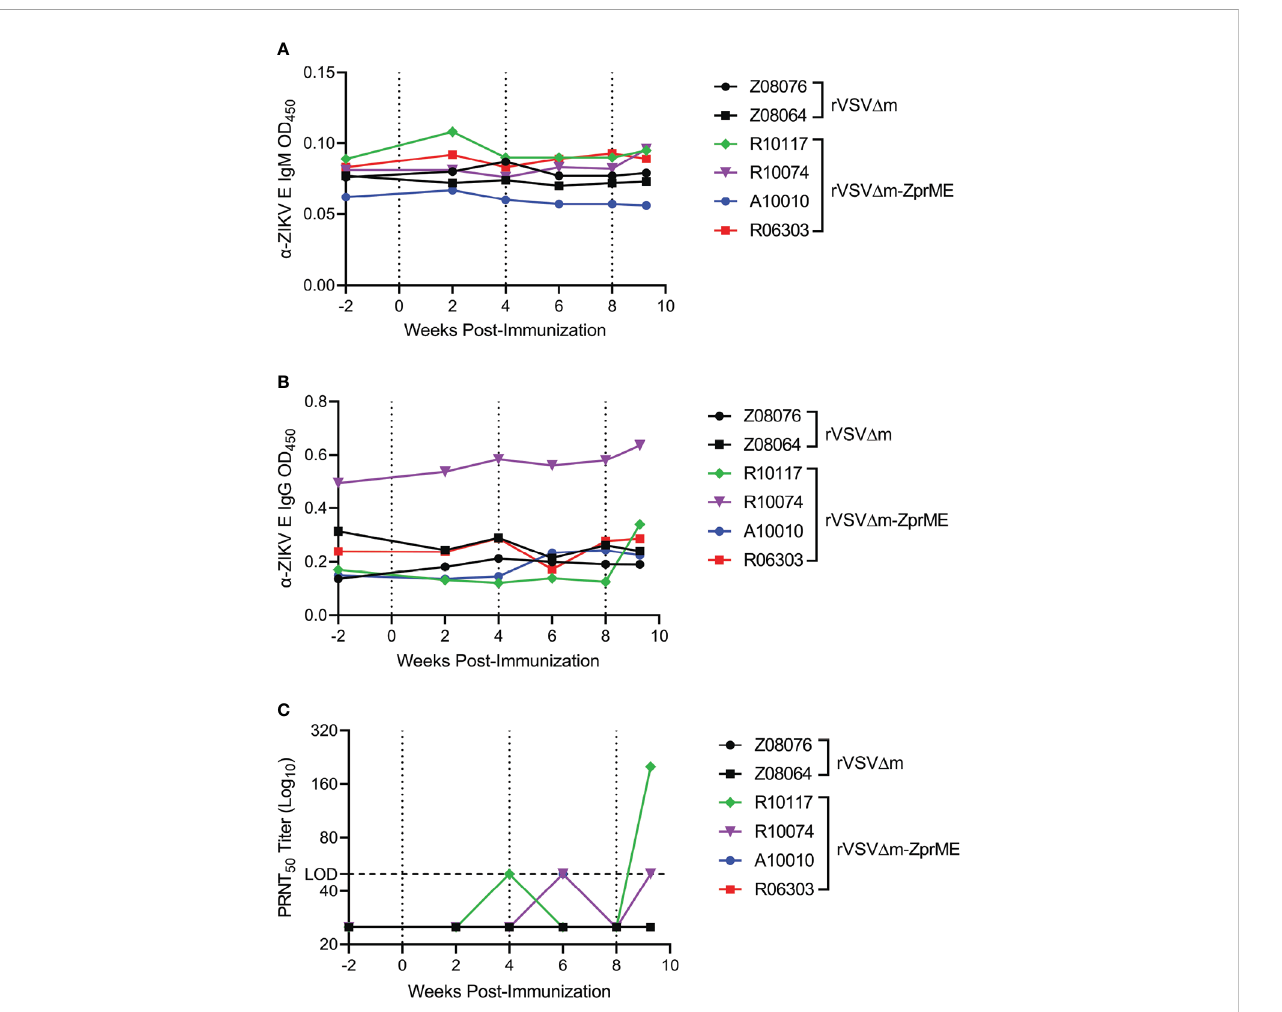
FIGURE 3 ZIKV-speci fi c Ig titers and ZIKV neutralization. Anti ( a )-ZIKV Env-speci fi c (A) IgM and (B) IgG responses in all animals were measured by ELISA (OD450 nm). Samples were diluted 1:100 to run for each assay OD, Optical Density (C) Sera were diluted 1:50 and evaluated for virus neutralization by PRNT 50 assay against ZIKV FSS13025 (Cambodia, 2010). The PRNT 50 50 lower limit neutralization value is marked by the dashed line. Neutralization tests were carried out in three independent assays. (A – C) Pre-immunization sera, serum samples collected biweekly after immunization, and pre-challenge samples were assayed. The data points on the plots represent individual animals for rVSV D M (black) and rVSV D M-ZprME (colored) vaccine regimens. Immunizations are indicated by the dotted